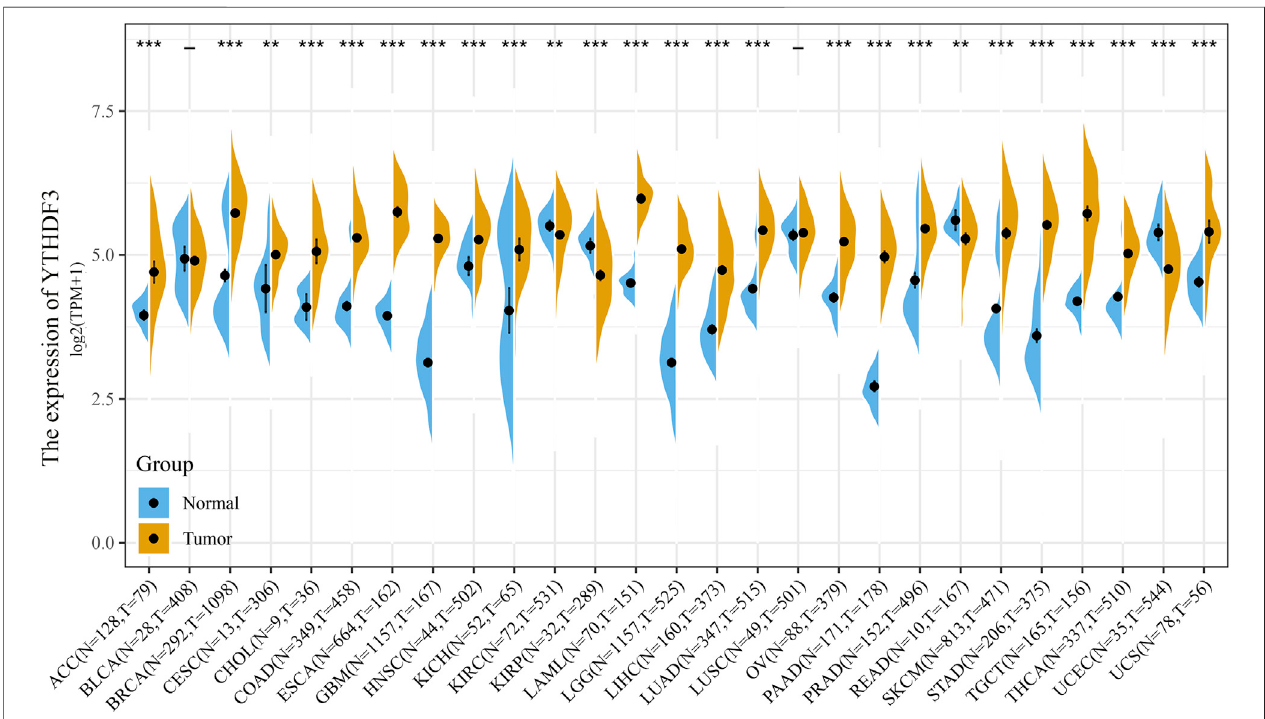
FIGURE 1 | YTHDF3 differential expression between normal and cancer tissues in 27 kinds of cancer was analyzed by TCGA and GTEx database. - no statistical difference, ** p < 0.01. *** p < 0.001.